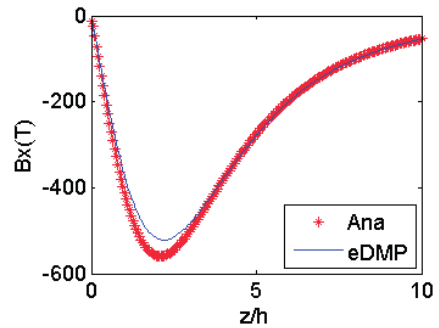
Figure 9. Field simulation results of coil b .